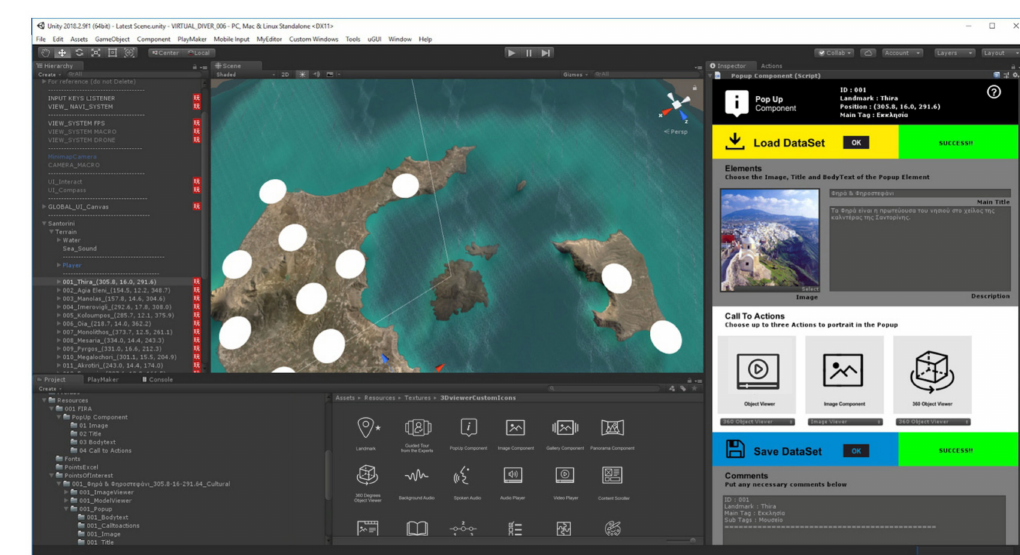
Figure 1. Screenshot from Unity Editor—Image Viewer Interaction Component Editor (on the right side of the